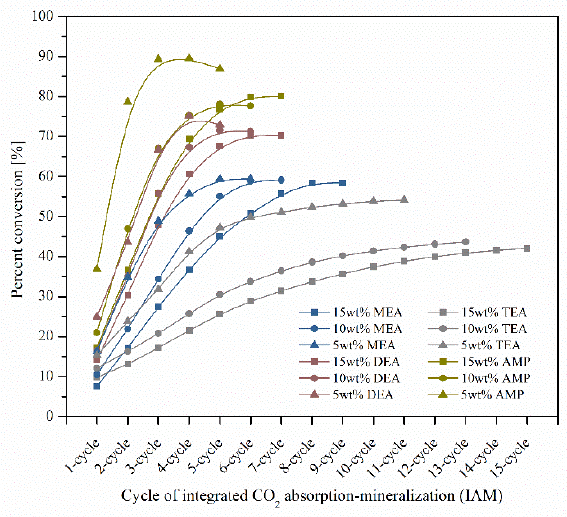
Figure 8. Percentage conversion of 5, 10, and 15 wt.% MEA, DEA, TEA, and AMP absorbents in multicycle IAM.